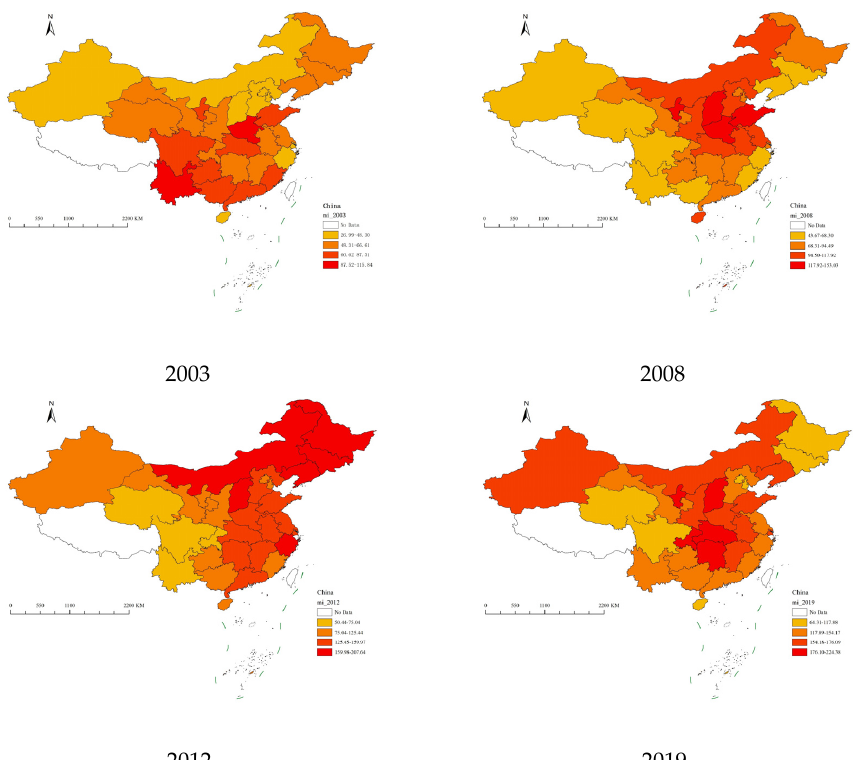
Figure 1. The level of market integration in China.